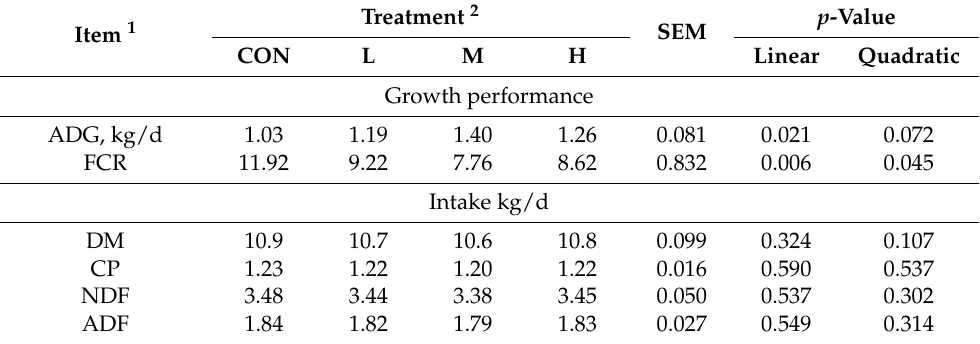
Table 2. Effect of supplementation with N-carbamylglutamate (NCG) on the growth and intake of fattening Holstein bulls.